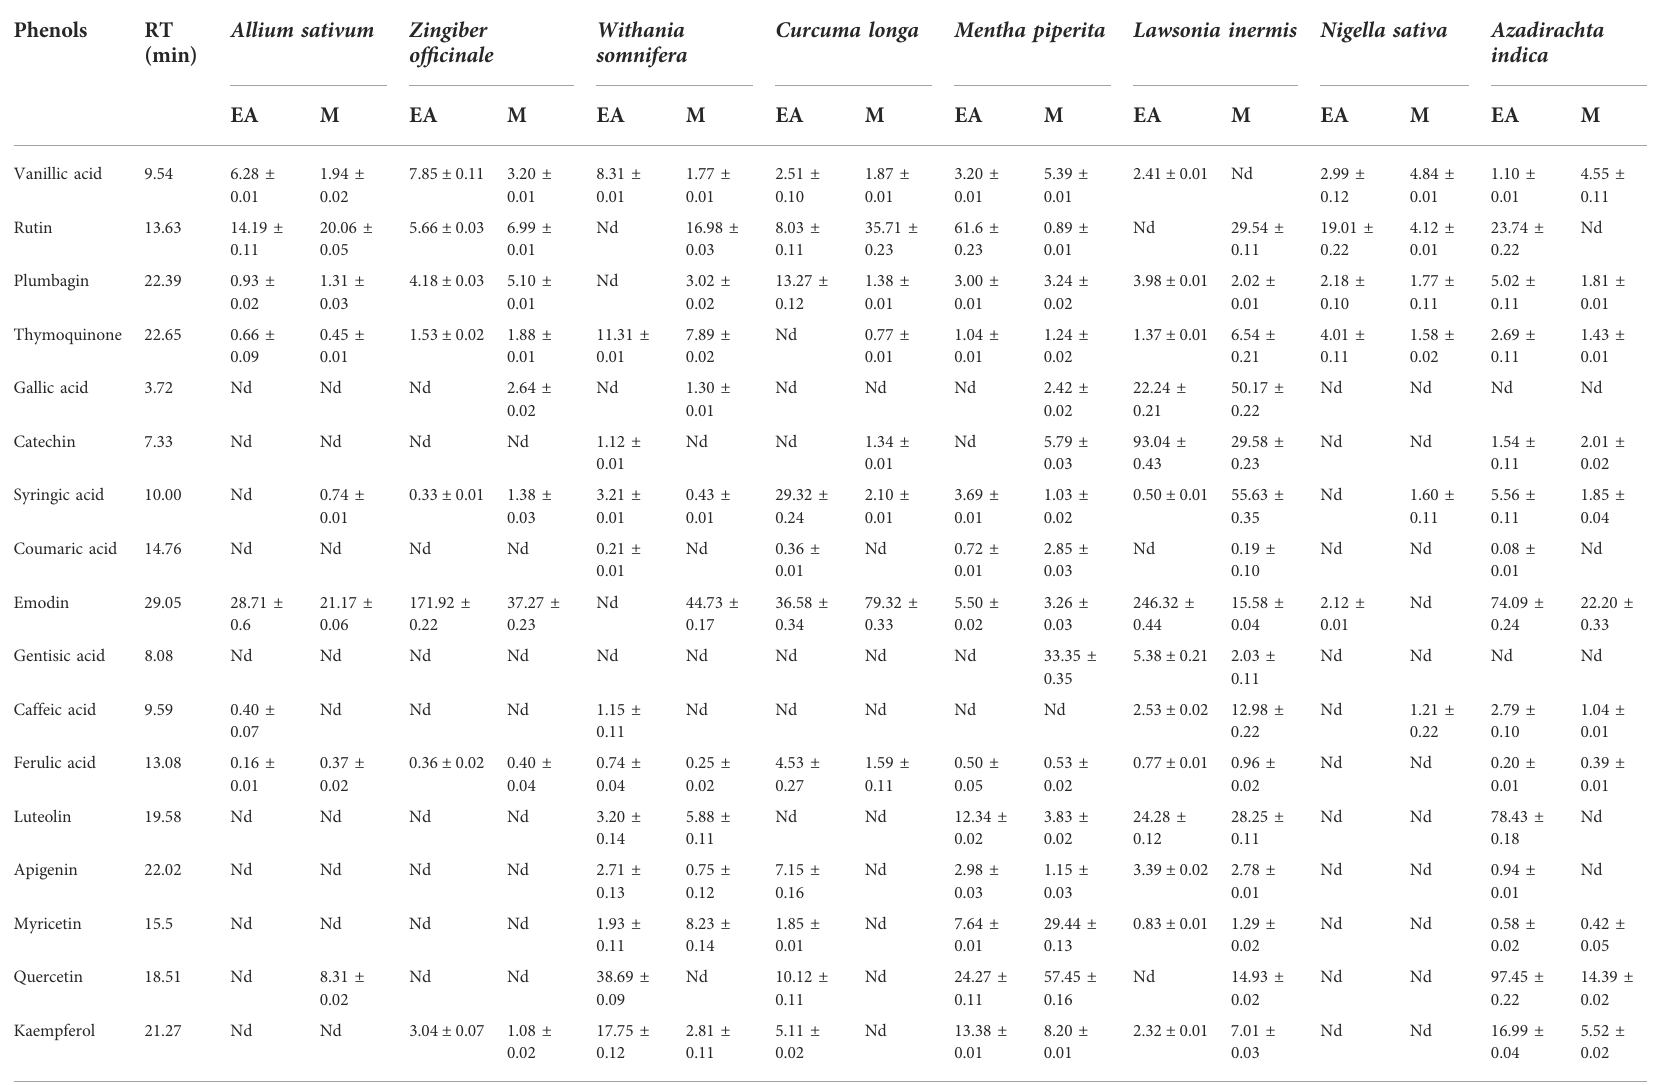
TABLE 3 HPLC based quanti fi cation of polyphenols in selected plant extracts. Concentration (µg/mg of extract) Phenols RT